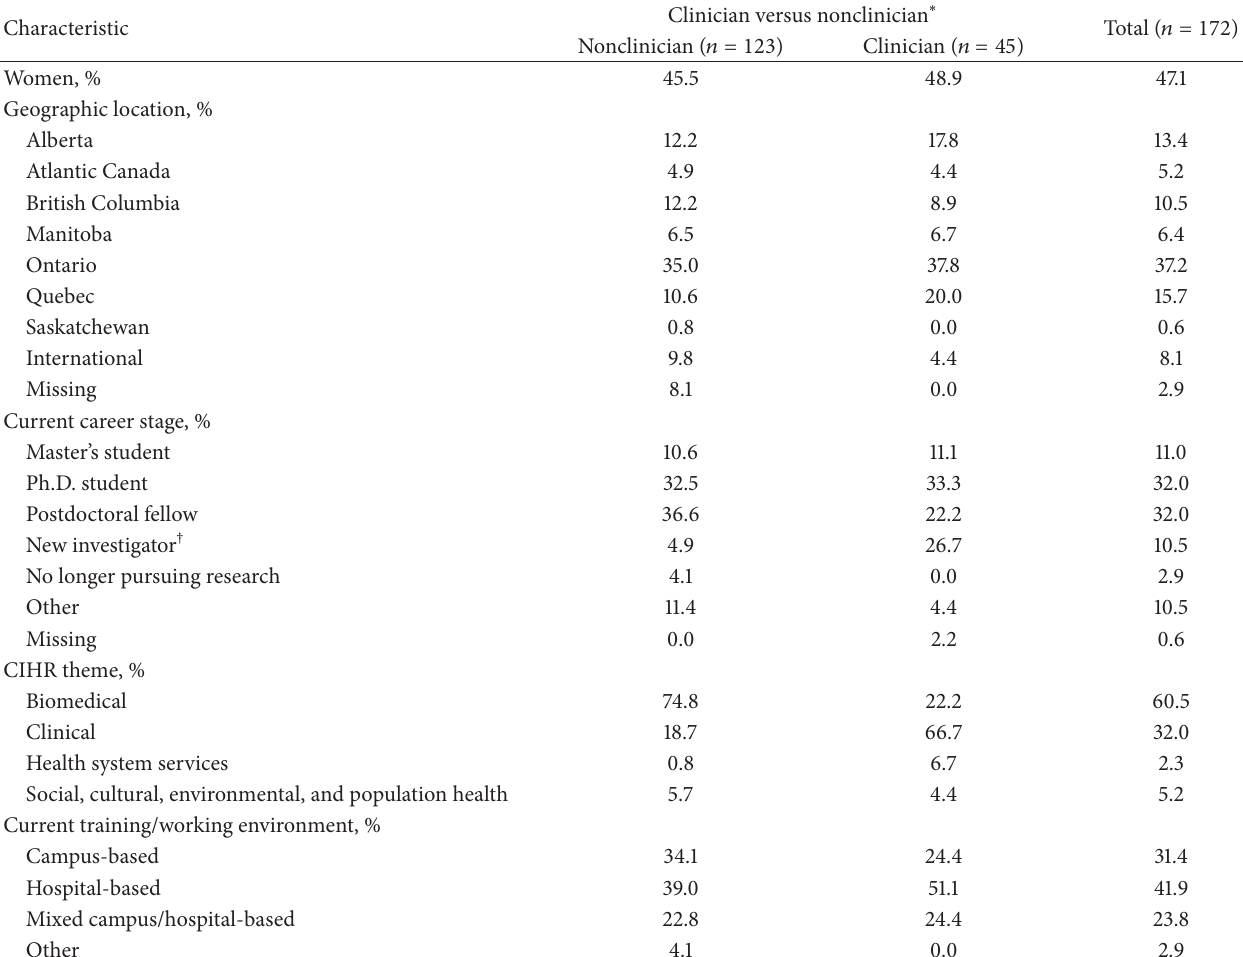
Table 1: Characteristics of participants in the ICRH